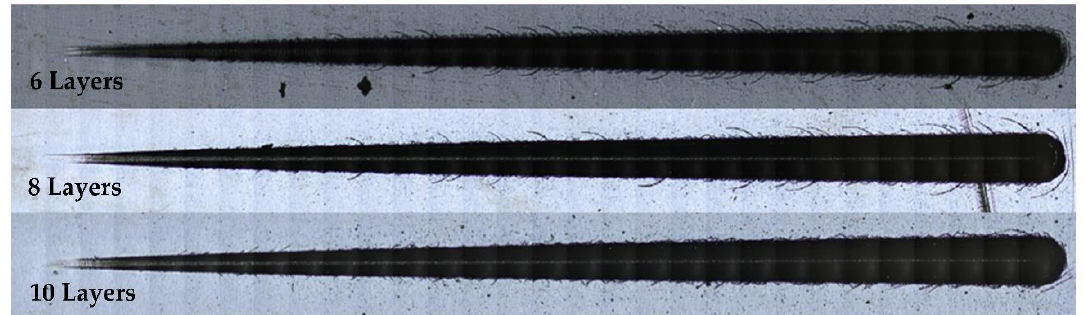
Figure 7. Some images of the scratches resulting from the scratch test to the “6 Layers” to “10 Layers” batch samples, obtained with an optical microscope.